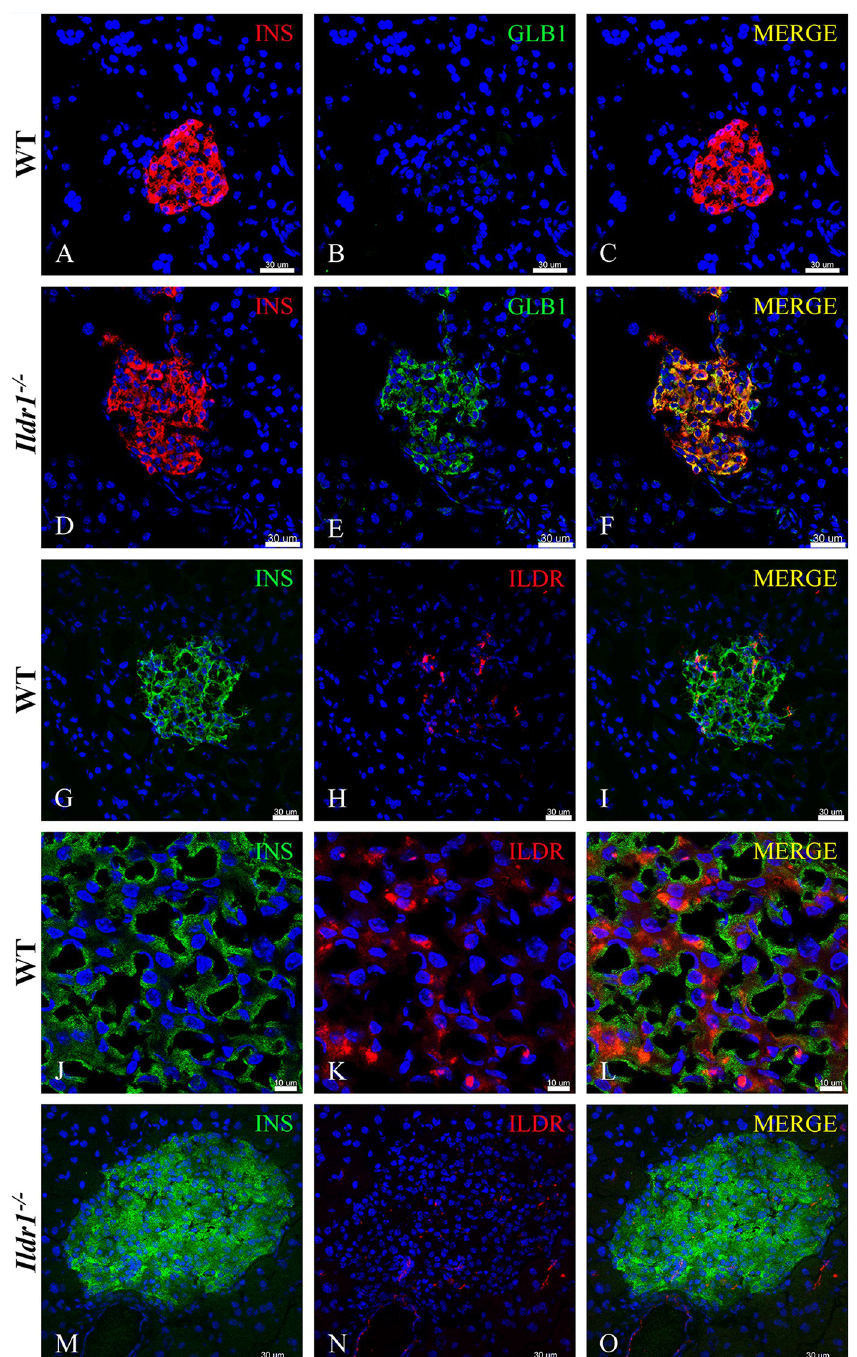
Fig 10. ILDR1 is expressed in pancreatic beta cells. (A-C) Insulin (red) and β -galactosidase reporter (green) staining in wild-type (WT) islets. (A) Insulin (red) expressing beta cells are present in the WT islet. (B) These cells are negative for the β -galactosidase reporter (green). (C) Merged image of insulin and β -galactosidase reporter immunostaining. (D-F) Insulin (red) and β -galactosidase reporter (green) staining in Ildr1 -/- islet. (D) Insulin (red) expressing beta cells are also present in the Ildr1 -/- islet. (E) β -galactosidase reporter (green) is expressed in Ildr1 -/- islet. (F) Merged image of insulin and β -galactosidase reporter immunostaining showing colocalization (yellow). (G-I) Insulin (green) and ILDR1 (red) immunostaining in wild-type (WT) islet. (G) Insulin immunostaining (green) in WT islet. (H) ILDR immunostaining (red) in WT islet. (I) While the ILDR1 immunostaining is faint, it co-localizes with insulin in islets of WT mice. (J-L) A high resolution airy scan image of insulin (green) and ILDR1 (red) in islet of WT mice. (J) Insulin